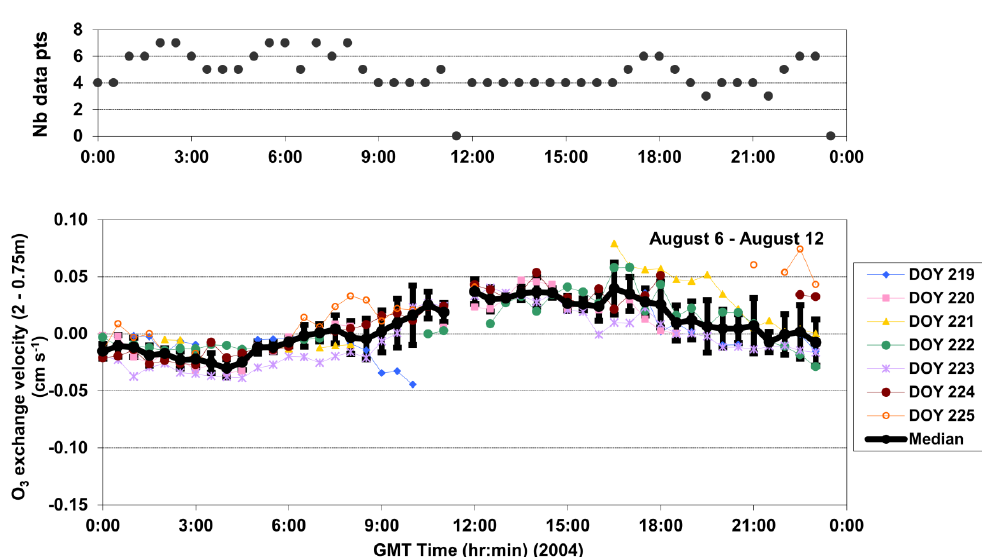
Fig. 9. Mean diurnal cycle of ozone v e for one week in spring (top; DOY 100-106 [9–25 April]) and summer (bottom; DOY 219-225 [6– 12 August]). Both graphs also show the number of individual data points (days) that went into the mean and standard deviation (as indicated by the error bar)